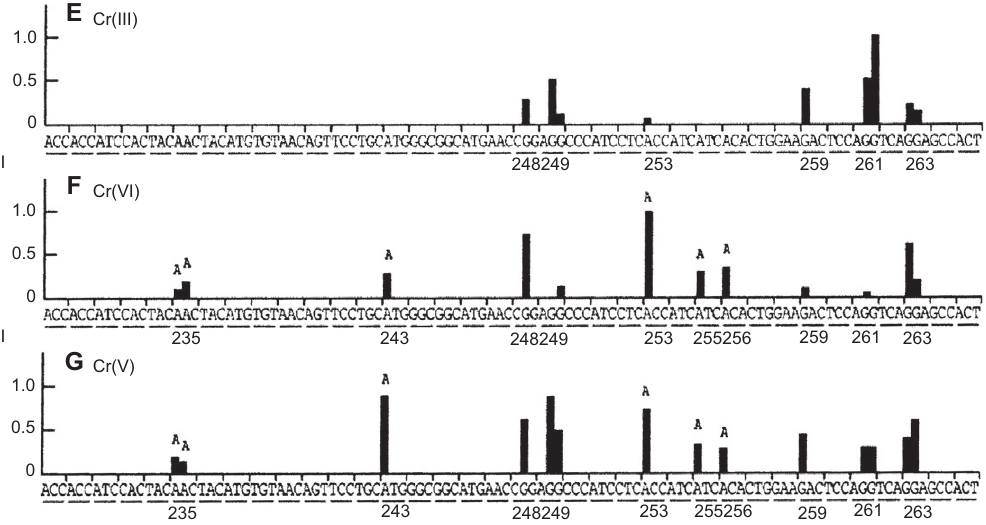
Figure 2 Reprinted with permission from Arakawa et al. (4) , copyright 2012 Oxford University Press. The figure depicts the distribution of Cr(III), Cr(VI), and Cr(V) adducts induced in exon 7 of the p53 gene in human lung cells. It is found that Cr(III) forms adducts at guanines only. The patterns of Cr(VI) and Cr(V) are almost similar with the latter showing a bit more adduct formation; the adducts are formed both at guanines and adenines, particularly at -CA- or -CAA-